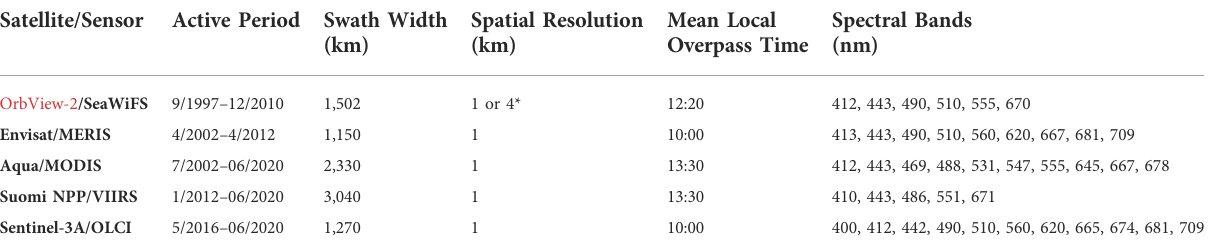
TABLE1OverviewofsatellitemissionsusedintheOC-CCIdataset.Thespatialresolutionisgivenforvaluespriortocombiningthedatasetsfromthe different missions (from Jackson, 2020). Satellite/Sensor